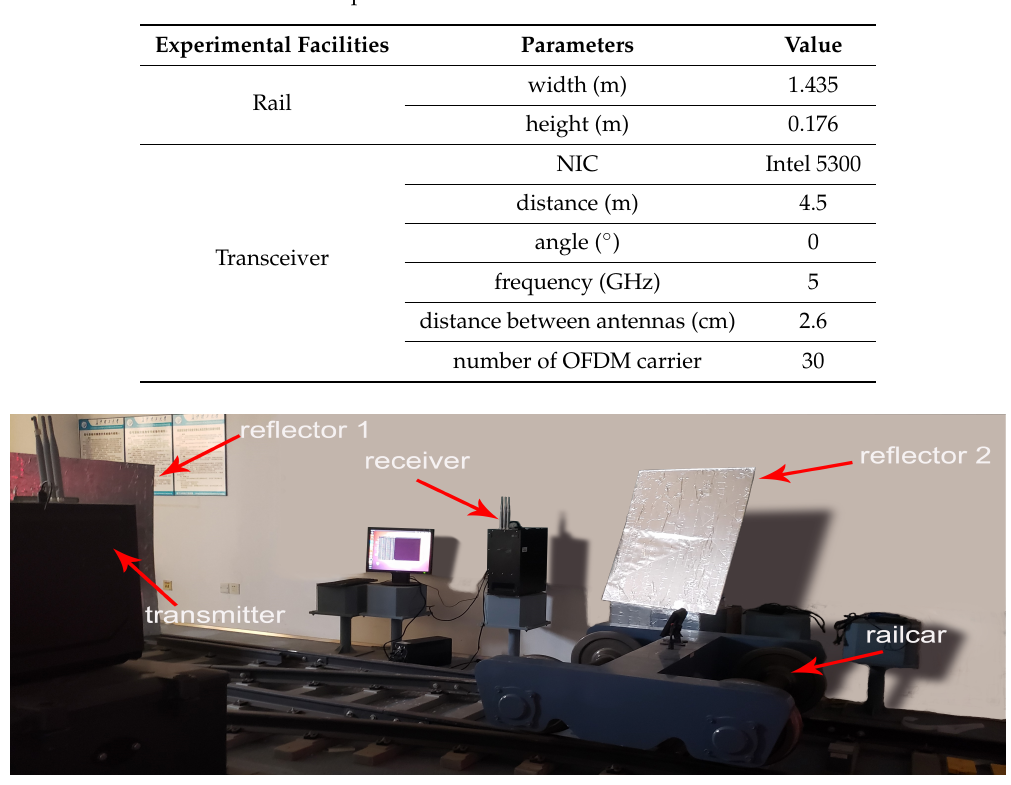
Figure 9. Photographs of the experimental